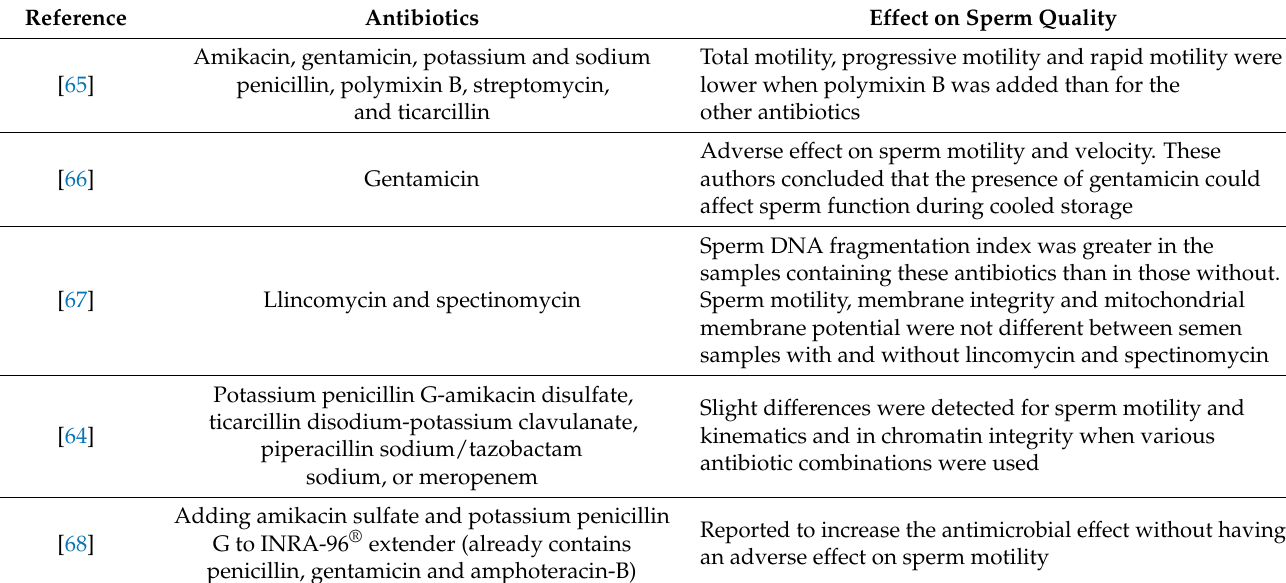
Table 2. Effects of antibiotics in semen extenders on sperm